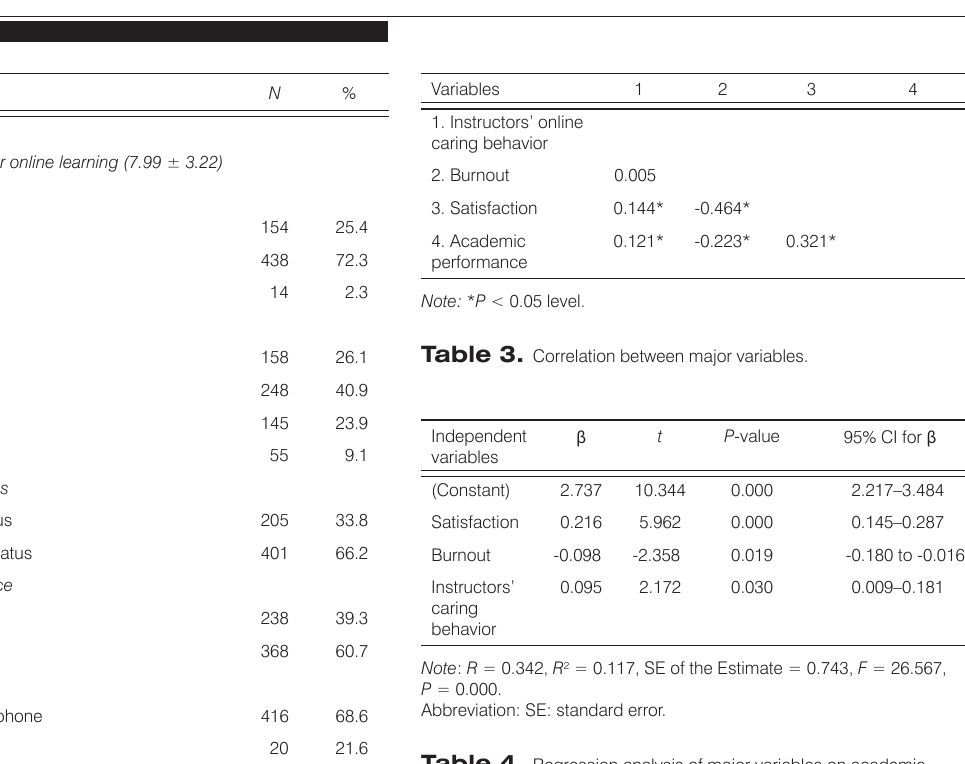
Table 4. Regression analysis of major variables on academic